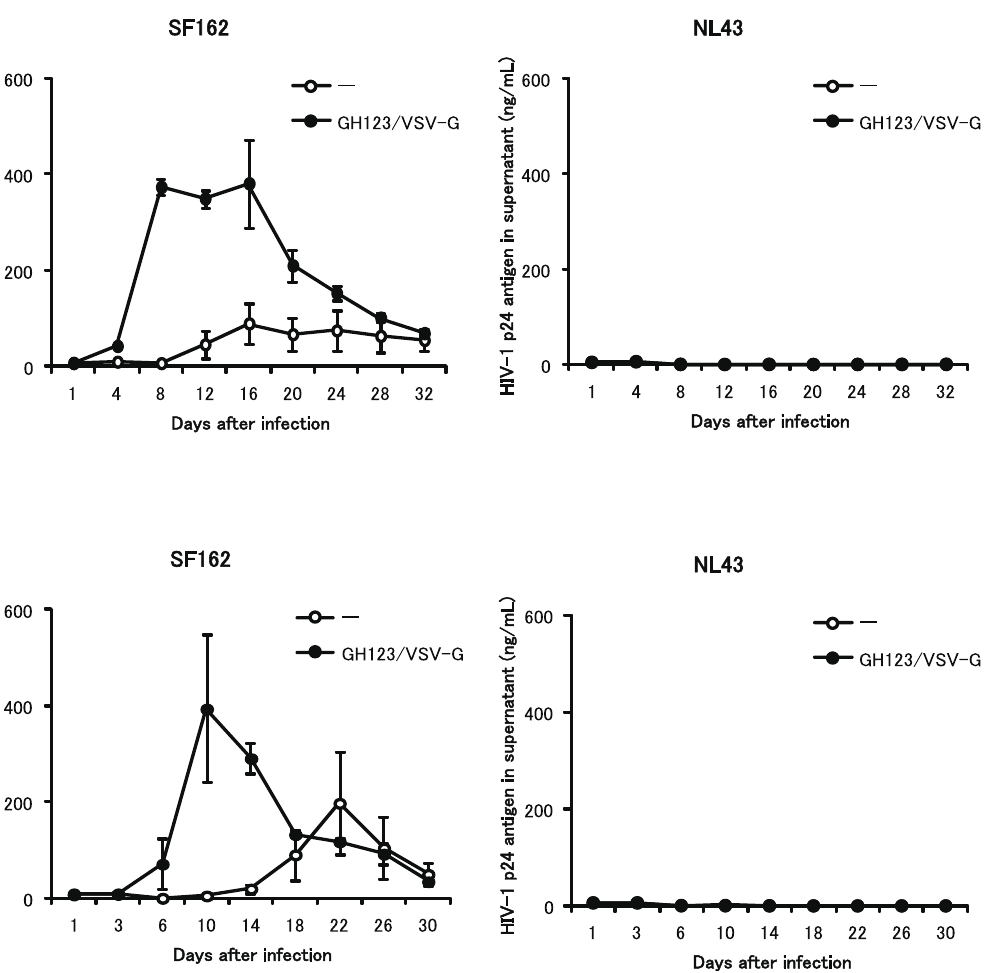
Figure 4. Effects of VSV-G-pseudotyped HIV-2 particles on macrophage-tropic and T-cell line-tropic HIV-1 strains in undifferentiated monocytes. Monocytes were treated with VSV-G pseudotyped and Env-defective HIV-2 particles (GH123/VSV-G) and then infected with HIV-1 strain SF162 or NL43. HIV-1 replication was quantified by ELISA measurement of p24 antigen in the supernatant after infection. Data are plotted as the mean 6 SD of triplicate samples obtained from a single blood donor; presented data are representative of three independent experiments using two donors. A: Results of samples obtained from a donor 1. B: Results of samples obtained from a donor 2.